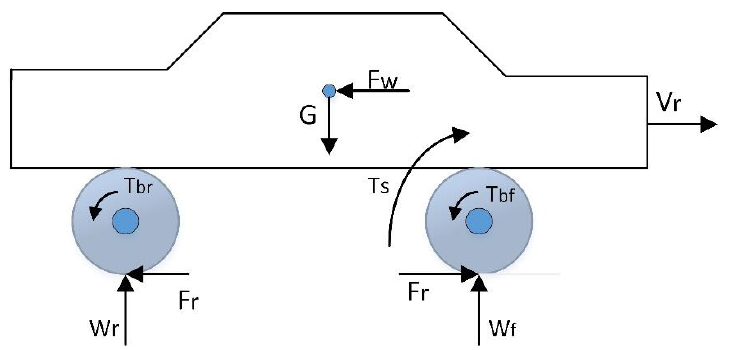
Figure 1. Diagram of vehicle force during braking.